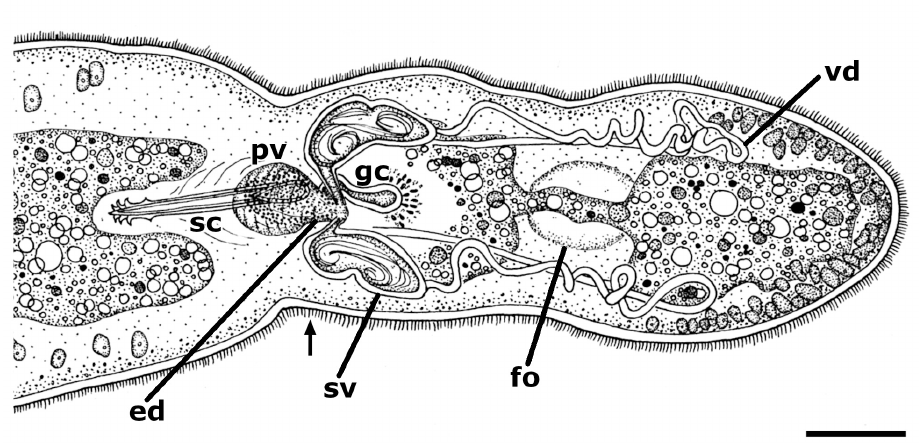
Fig. 2. Posterior end of Coelogynopora kenichii sp. nov. in ventral view, from a whole mount (RMNH. VER.19980.a). Scale bar = 50